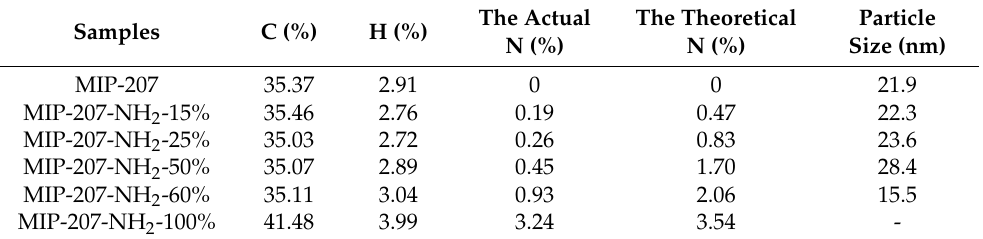
Table 1. The content of C, H, and N elements of samples and particle size obtained by Scherrer equation.